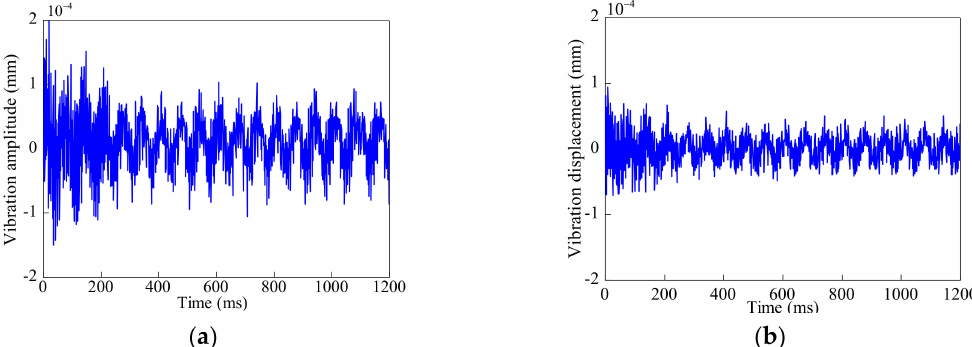
Figure 18. Waveforms of vibration displacement in the Y-direction of point A on the motor. ( a ) Prototype motor; ( b ) Optimized